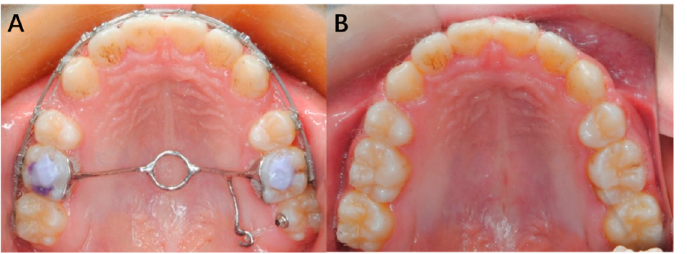
Figure 8. ( A ) A 3D TPA with a lateral arm, used to correct buccally flared second molar; ( B ) the buccally flared second molar corrected using the 3D TPA.